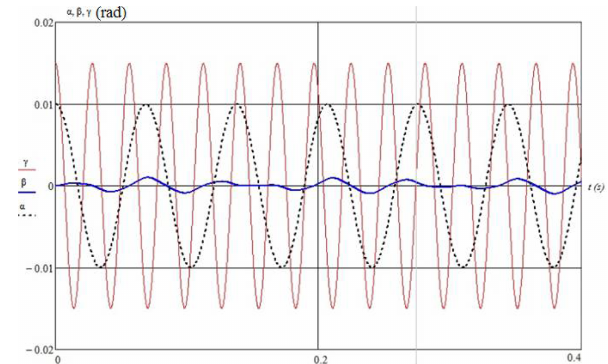
Figure 4. Deviation of the output link along the coordinates α , β , and γ .